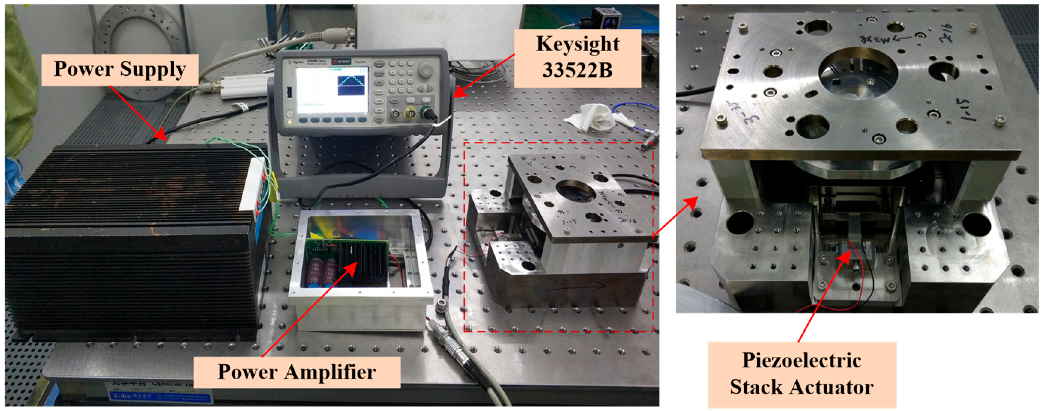
Figure 23. The setup of the tests in the system.